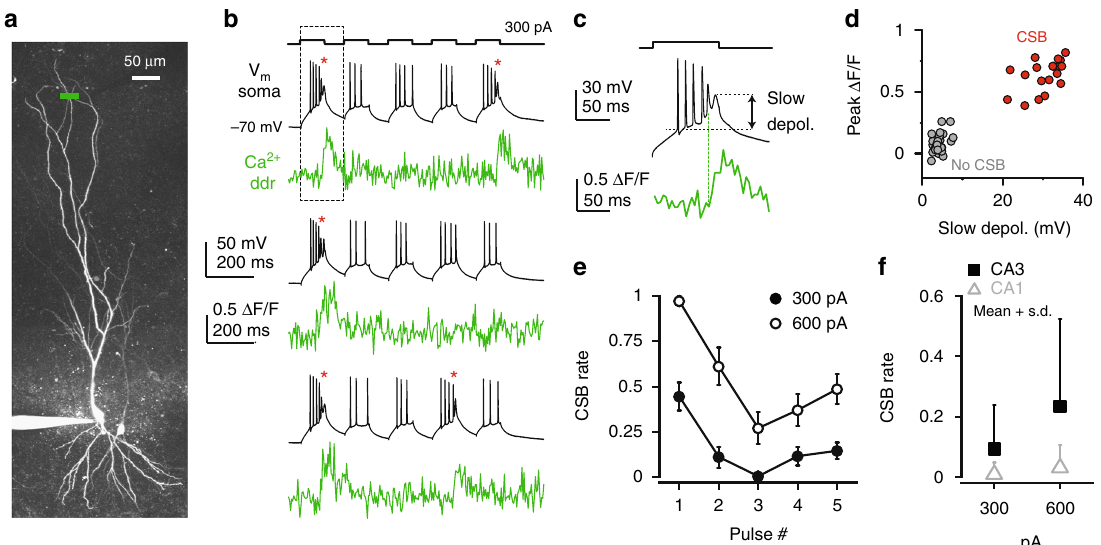
Fig. 1 Complex spike bursts in CA3PCs. a Z-stack of a CA3PCs loaded with 50 μ M Alexa594 and 100 μ M OGB-6F. Ca 2 + imaging line is indicated in green. b Three representative somatic current-clamp and corresponding dendritic (ddr) Ca 2 + traces recorded in the cell shown in a . Complex spike bursts are marked by red asterisks. Current injection protocol is shown on top. c Magni fi ed traces from the dashed box in b , illustrating the slow depolarization underlying CSB and the time-locked dendritic Ca 2 + signal. d Results of the total 50 pulses of 10 traces recorded from the cell shown in a – c . Note the separation of pulses with and without CSBs. e CSB rate on different pulses in the train. A set of 20 cells that produced CSBs at 300 pA I inj were included in the analysis. Symbols and error bars represent mean ± s.e.m. f CSB rate at 300 and 600 pA I inj in CA3PCs ( n = 118 and 117 cells, respectively) and CA1PCs ( n = 26 cells). Symbols and error bars in f represent mean + s.d. Source data are provided as a Source Data fi le